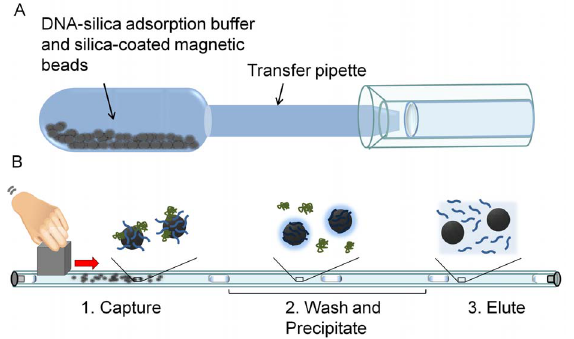
Figure 1. The two components of the magnetic bead-based extraction method. A) DNA is adsorbed to silica-coated magnetic beads previously lyophilized with DNA-silica adsorption buffer in the bulb of a transfer pipette. After mixing, the beads are transferred directly into the small diameter tubing by depressing the bulb. B) The small diameter tubing ‘‘extraction cassette’’ is shown with processing solutions separated by air gaps. DNA adsorbed to silica-coated magnetic beads is pulled through each processing solution by an external magnet and eluted in the final water chamber.